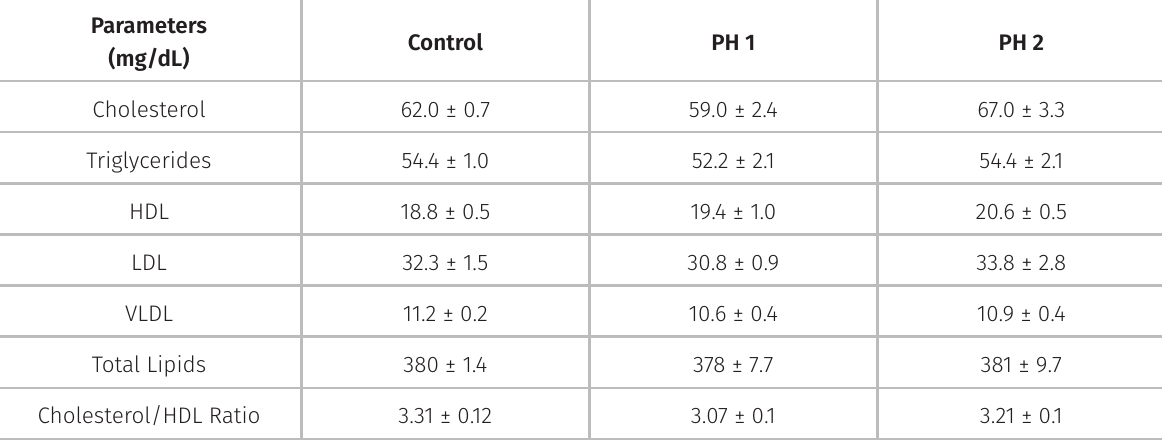
Table III. Effect of polyherbal products on lipid profile of rats in acute toxicity